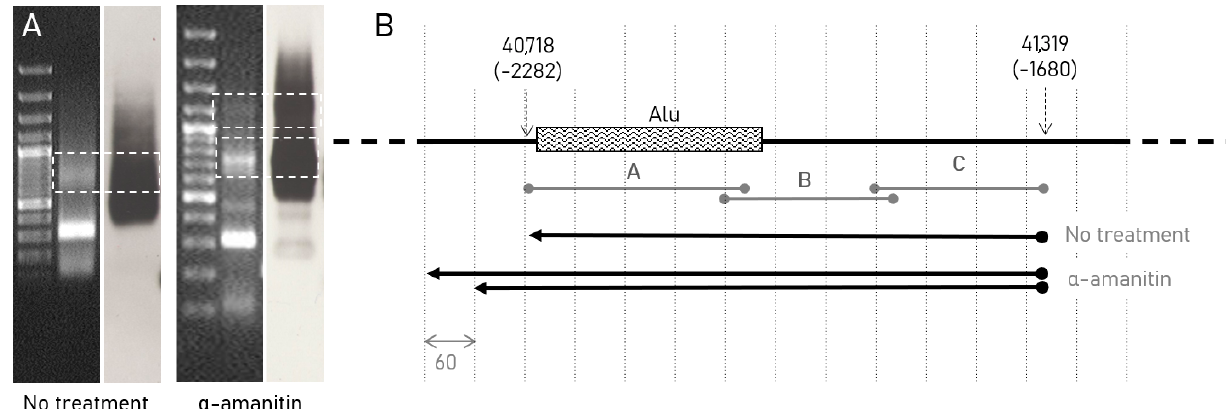
Figure 4. Mapping of the transcripts in the pre-promoter zone of rIGS. ( A ) Electrophoresis and Southern blot of cDNAs from non-treated and alpha-amanitin treated cells 30 µg/mL obtained with 3 ′ RACE experiments, dotted rectangles showing the bands taken for cloning and subsequent sequencing; ( B ) Mapping of the sequences obtained from 3 ′ RACEs to the region of interest. Sequences and their pairwise alignments are available in the supplementary section (Supplementary S1 and S2) or can be found using the GenBank accession numbers MW459196-MW459199.